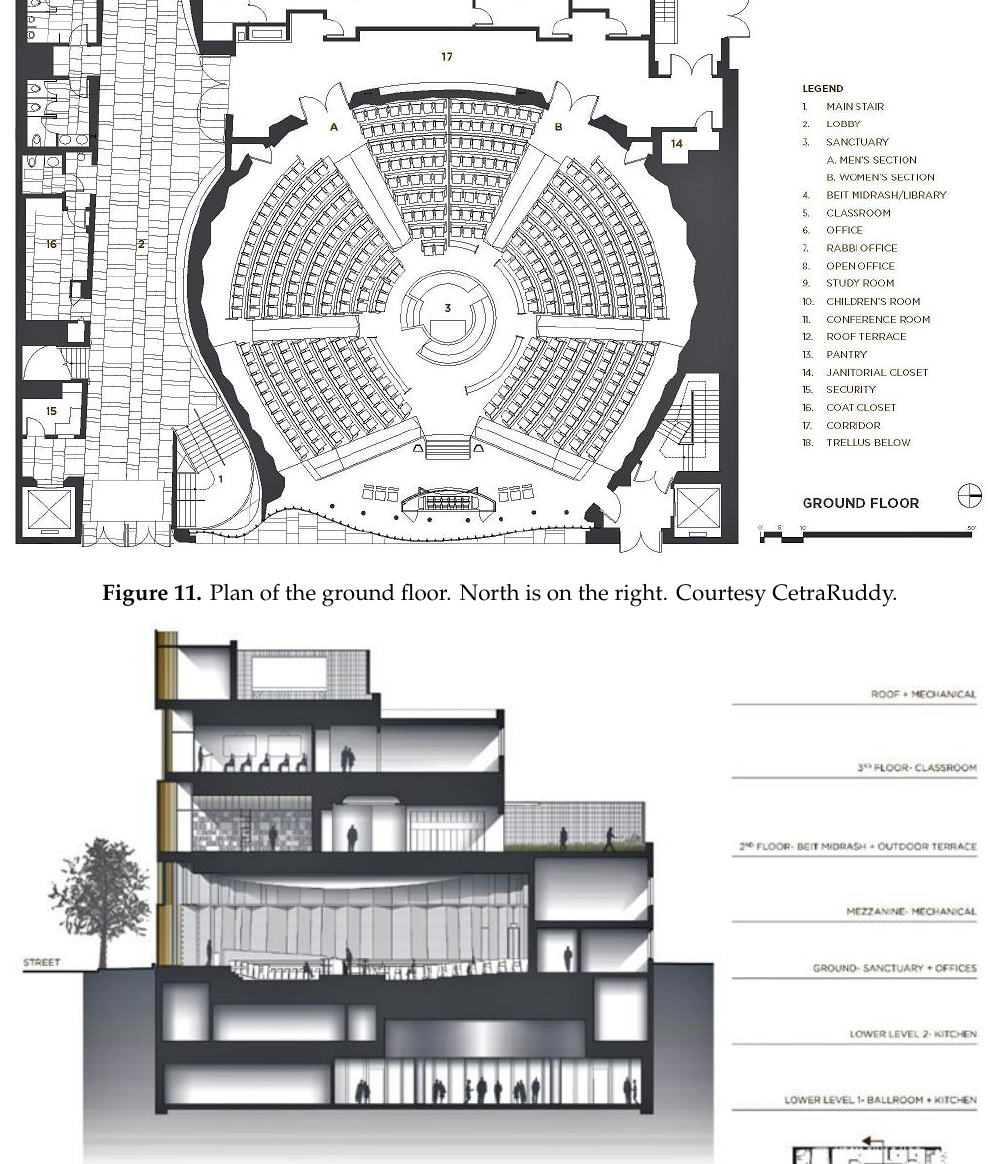
Figure 12. Section looking south. Courtesy CetraRuddy.